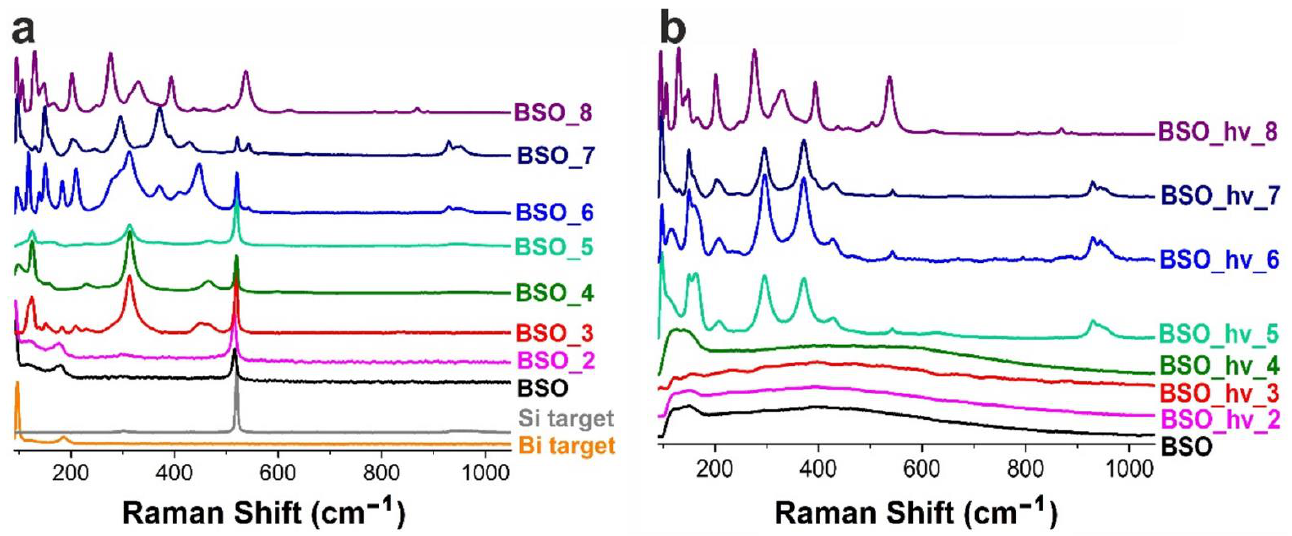
Figure 4. Raman spectra of the BSO ( a ) and BSO_hν ( b ) groups of